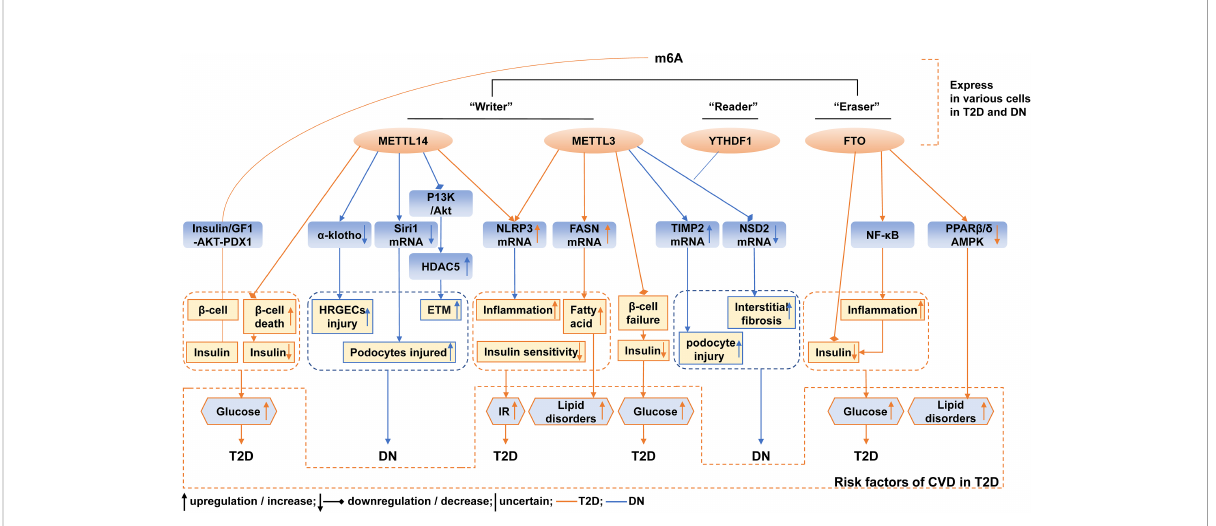
FIGURE 12 Schematic illustration of current mechanism of m 6 A and methylesterase in T2D and DN, and CVD risk factors associated with m 6 A and methylesterase in T2D. The orange lines represent mechanisms associated with T2D, and the blue lines represent mechanisms associated with